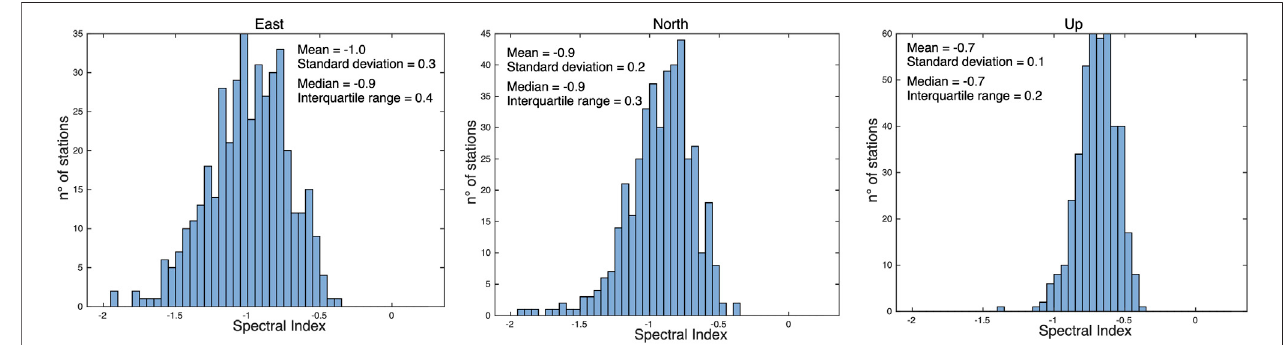
FIGURE 4 | Distribution of the spectral index values estimated on the East, North and Vertical components using the HECTOR software, assuming a PL + WN noise model.